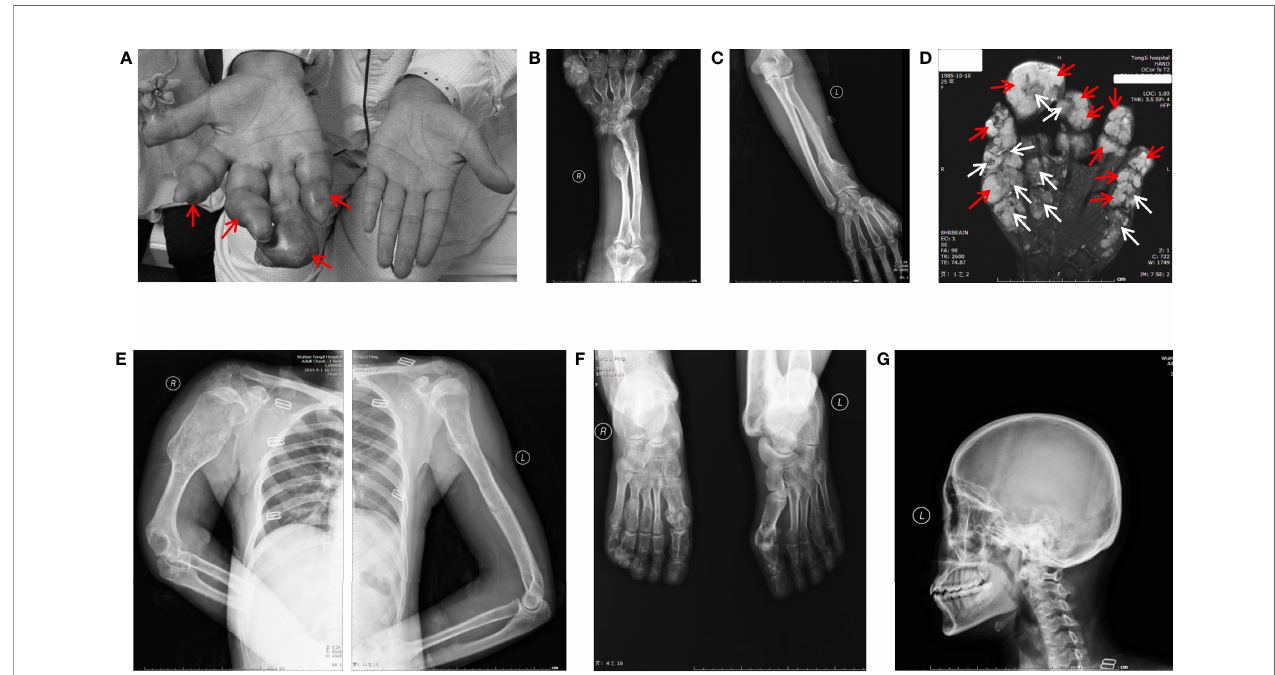
FIGURE 1 | General view and radiographic imaging of the lesion. (A) The right hand of the patient with Maffucci ’ s syndrome showed deformities due to multiple enchondromas and a super fi cial hemangioma. The red arrows show hemangioma as a soft spherical bulge in light blue. (B) X-ray images of the right ulnar and radial bones and multiple metacarpophalangeal bones of the right hand show multiple reduced bone densities and partial expansive bone destruction (C) . The X-ray shows a relatively normal bone mass in the left arm. (D) MR results of the patient ’ s right hand showed the phalanges are circular or oval, multilocular, well-de fi ned, iso- intensity and hyperintensity on T2WI (white arrows) and the soft tissue around the phalanx presents dilatative, well-bounded hyperintensity on T2WI (red arrows). (E) X-ray images of the patient ’ s upper body and enlarged right arm are shown in the fi lm. (F) X-ray images of the patient ’ s feet have the same radiographic appearance as those of the upper limbs. (G) X-ray image of cranial and maxillofacial bones showed no apparent